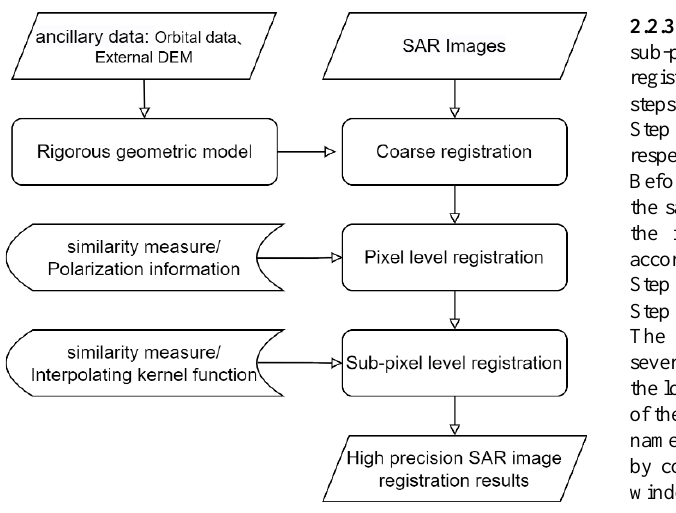
Figure 2 . Diagram illustrates the interferometric registration